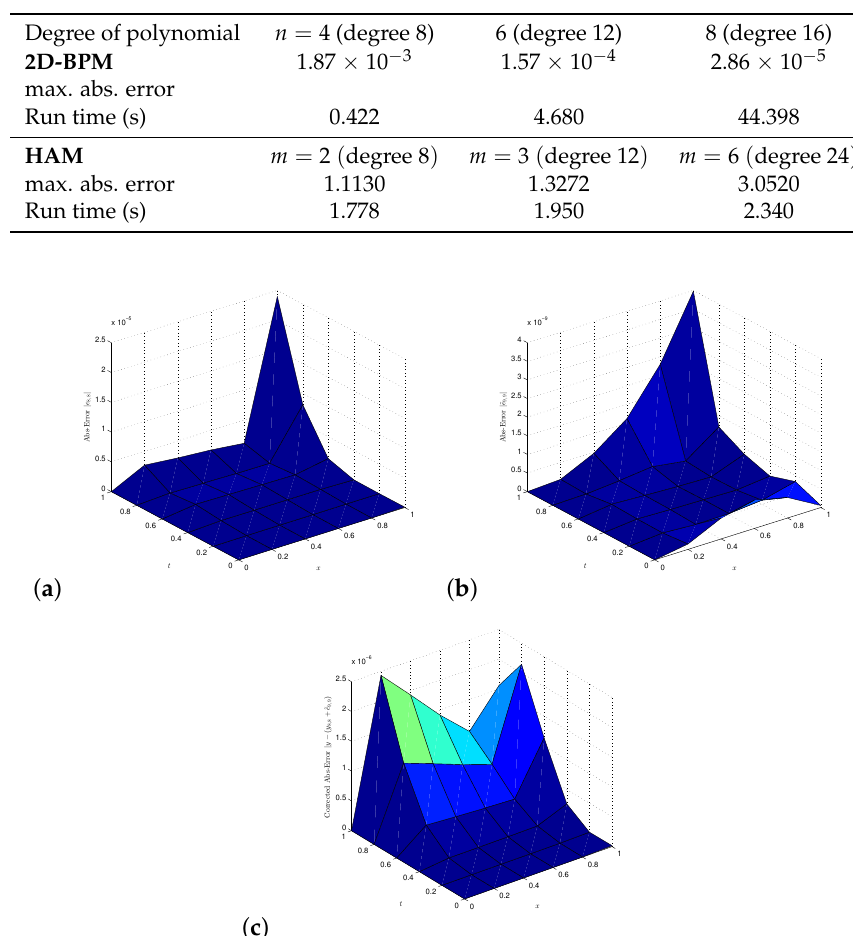
Table 7. The results of the 2D-BPM and HAM for Example 3.